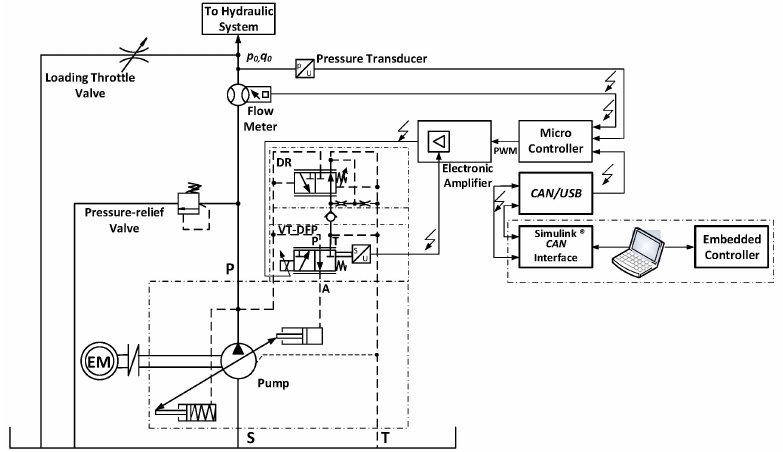
Figure 1. System for rapid prototyping of control algorithms for axial piston pumps.